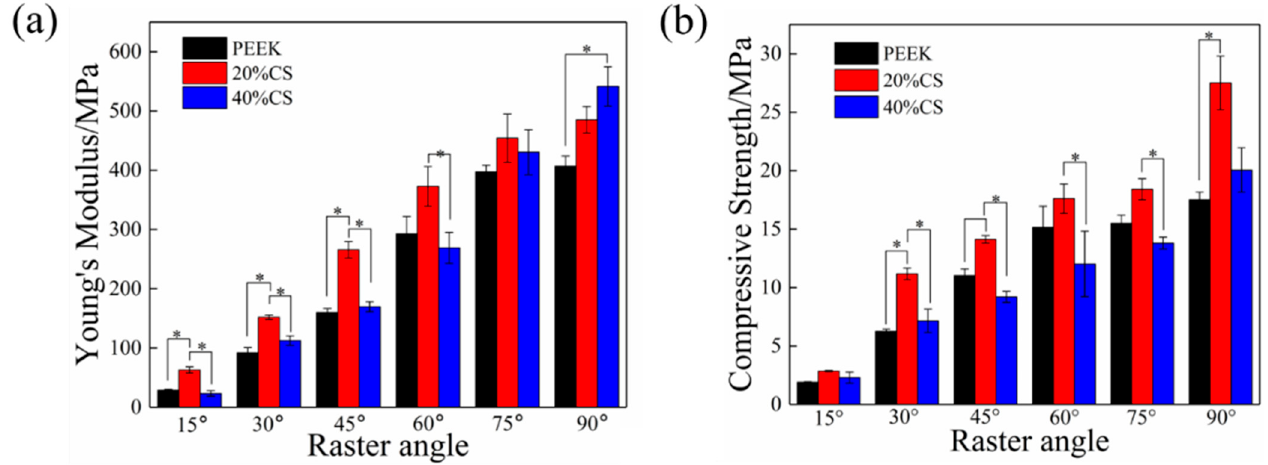
Figure 4. The modulus ( a ) and strength ( b ) results of the scaffolds with different CS content and raster angles.